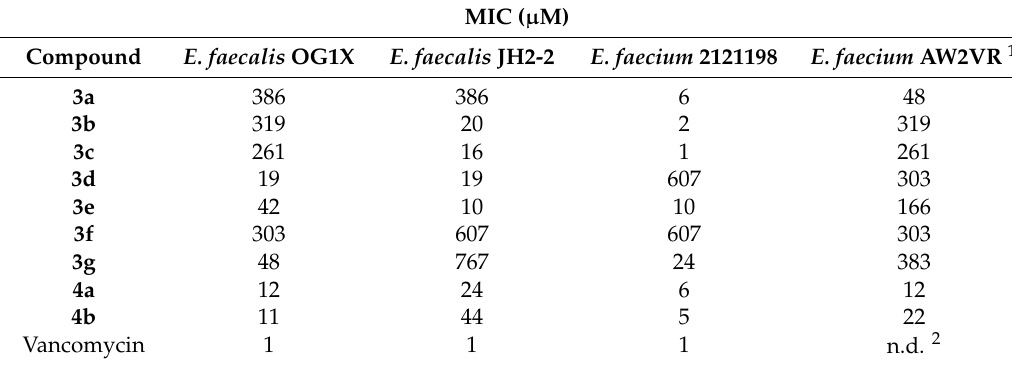
Table 1. Antibacterial activity of benzocarbazole types 3 and 4 against different Enterococcus faecalis and E. faecium